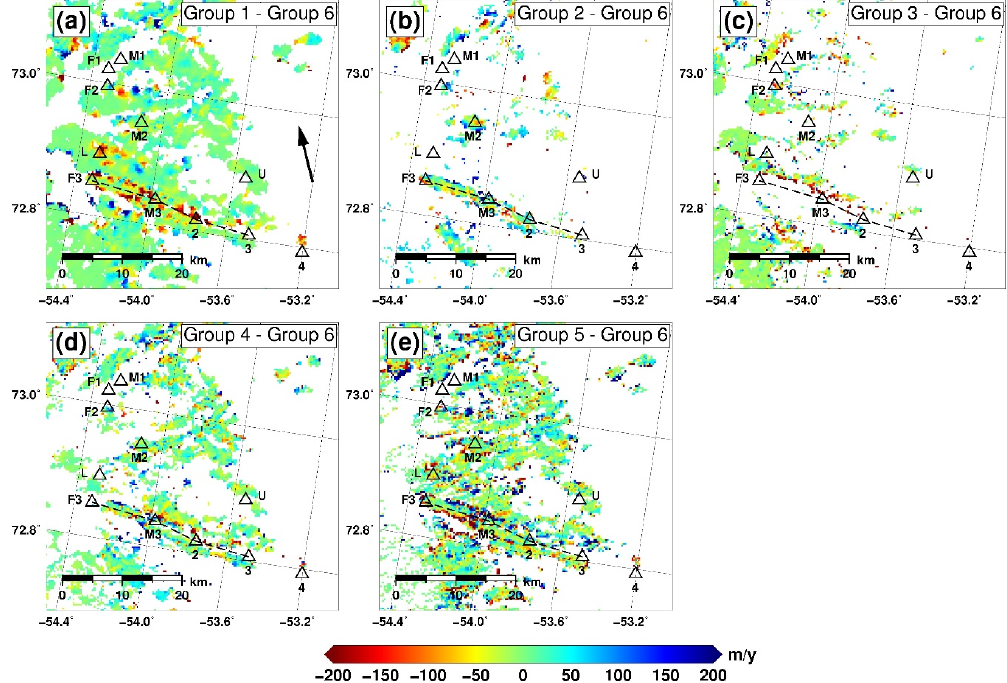
Figure 13. Task 3 azimuth velocity differences of groups 1 to 5 ( a – e ) with respect to group 6.